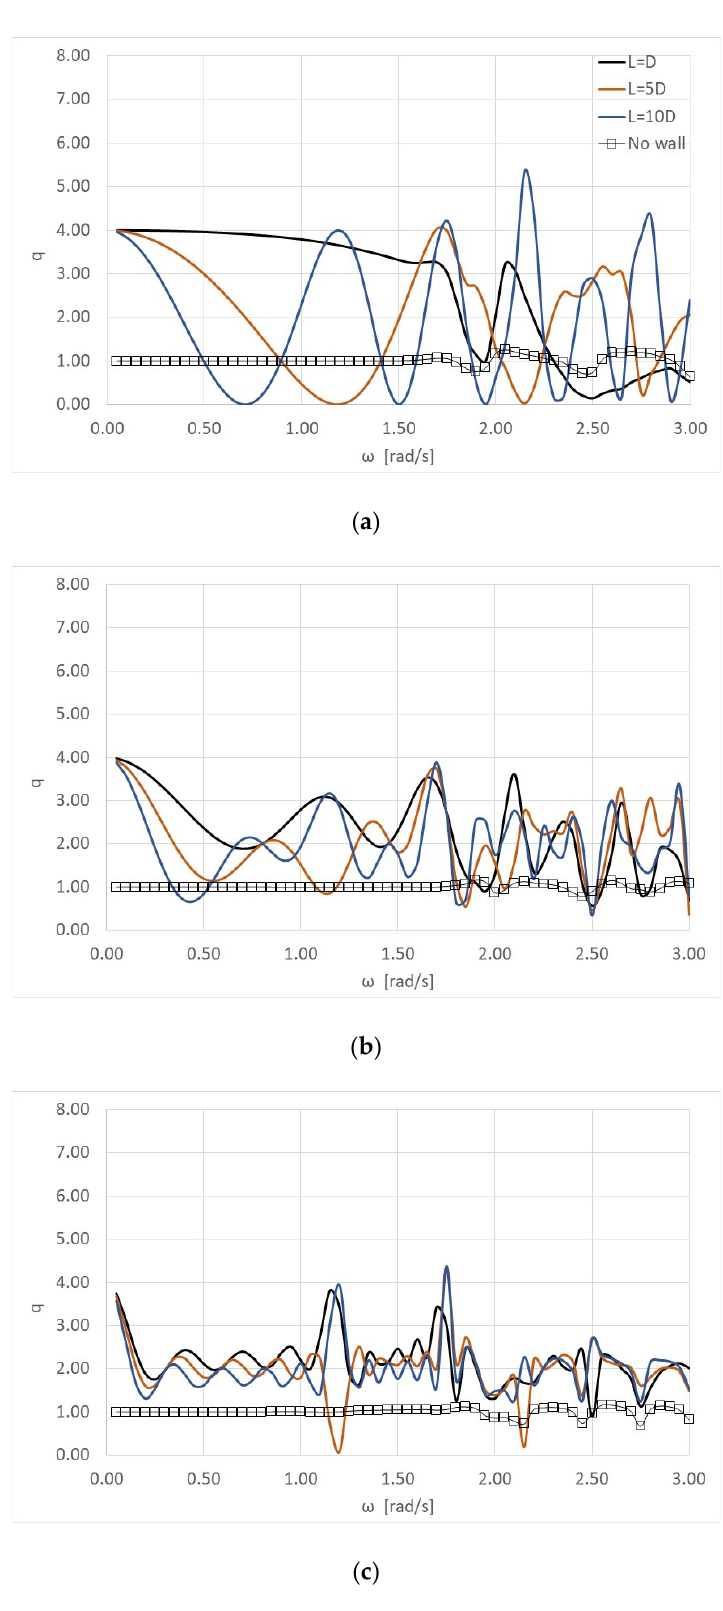
Figure 9. The q factor term of the WEC array, against ω , for the three different WEC–wall distance cases and for 0° wave heading angle. Comparison concerning the q factor of the same array without the presence of the breakwater: ( a ) parallel arrangement; ( b ) rectangular arrangement; ( c ) perpendicular arrangement.